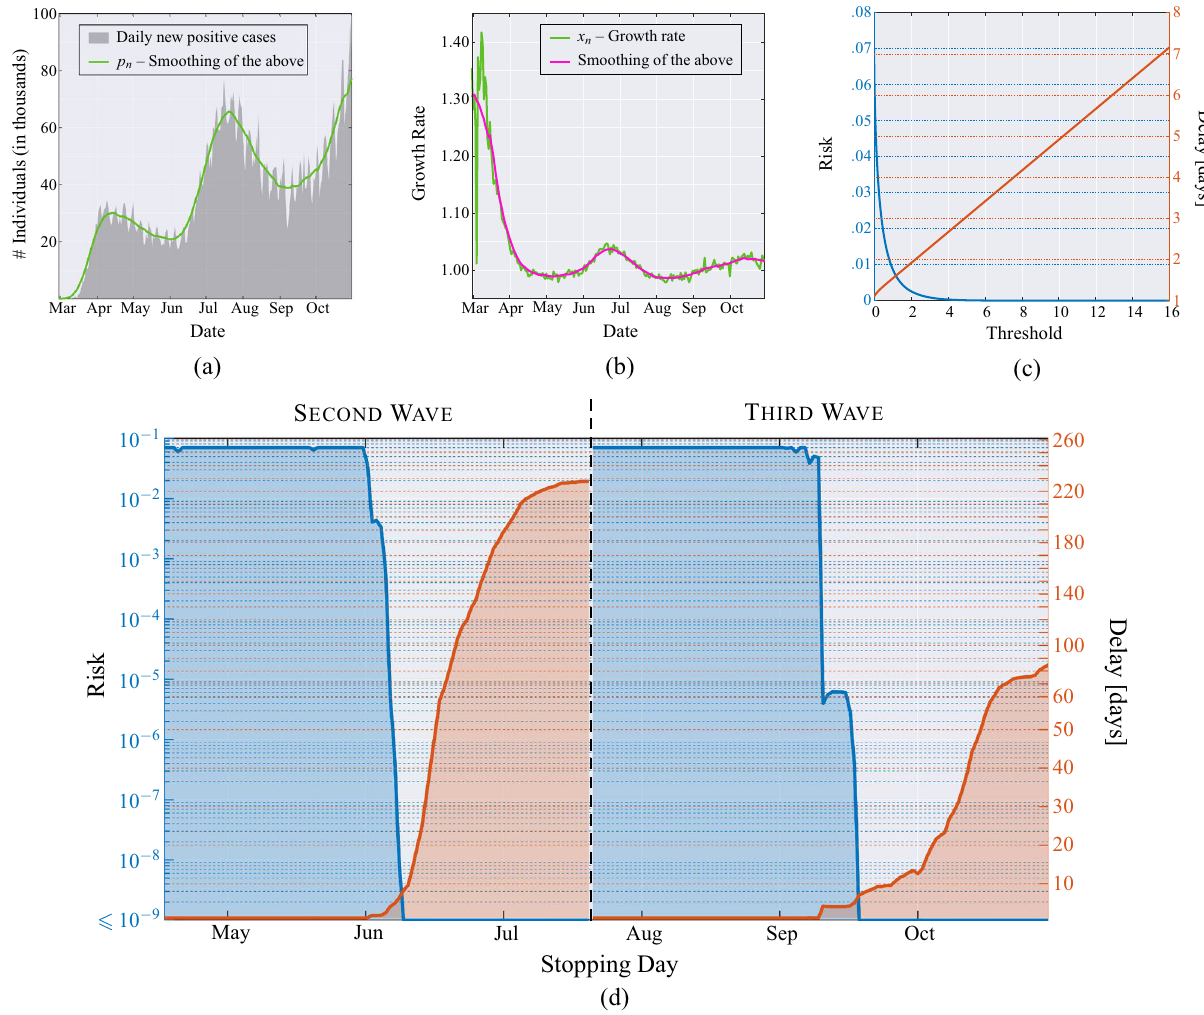
Figure 7. United States of America. ( a ) Daily new positive cases in the US since February 29, 2020, and its moving average obtained with a window of 21 days (green line). ( b ) Growth rate of the epidemic computed from the averaged daily new positive cases (green line), and its time-varying mean obtained through a moving average that uses a window of 21 days (magenta line). ( c ) MAST performance, in terms of risk (left axis) versus threshold and mean delay (right axis) versus threshold, obtained from the US data of the COVID-19 pandemic. ( d ) Application of the MAST procedure on the COVID-19 pandemic data from US. Both the second wave (left side) and the third wave (right side) are analysed. For each wave, we select a desired risk on the left-side vertical axis, e.g., R = 10 − 4 . Then, the blue curve indicates the stopping day (about June 6 for the first wave and September 10 for the third wave) corresponding to the selected value of risk. Finally, the red curve referred to the right-side vertical axis shows the mean delay (cid:31) corresponding to the selected risk R (approximately 4 days for both the second and the third waves). For clarity, note that the right-side scale for the delay is split into two linear ranges, for a better rendering of the small- (cid:31)